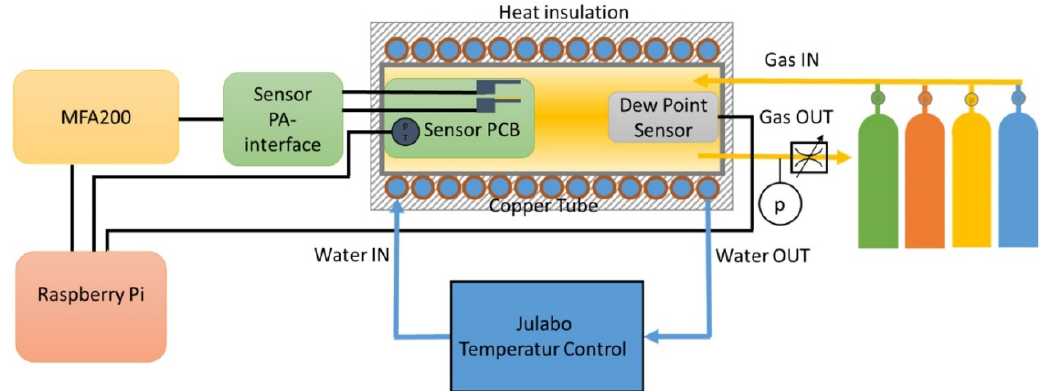
Figure 3. Schematic representation of the measurement setup.